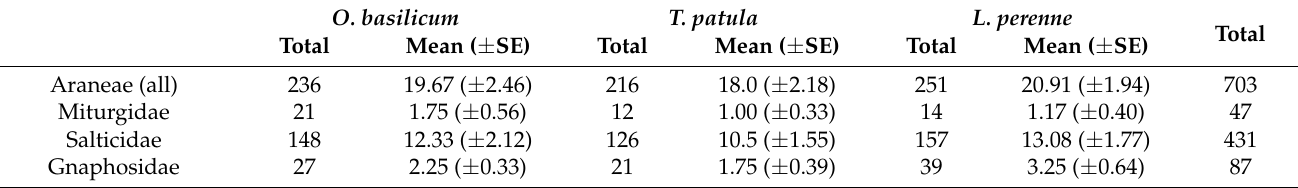
Table A1. Cumulative number of arthropods collected per tree along the sampling period in O. basilicum , T. patula, and L. perenne inter-cropping plots. Forficulidae cumulative numbers were estimated based on median values of interval abundance classes. The Shannon–Wiener diversity index measured the taxonomic diversity of the predator families (without